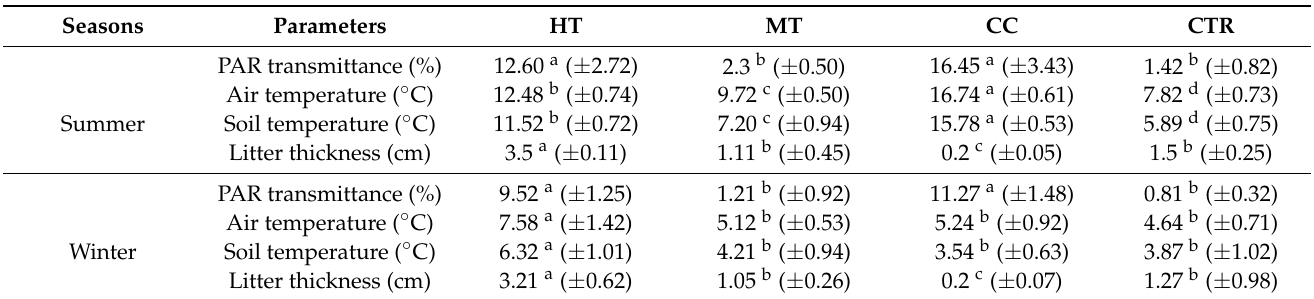
Table 1. Micro-environmental variables in high intensity thinning (HT), medium intensity thinning (MT), clear cut (CC), and control (CTR) plots in summer and winter. Different letters in the same row indicate, within each season, significant differences (Tukey’s test, p ≤ 0.05). The data are the means of two consecutive years (2014 and 2015). PAR: photosynthetically active radiation. Different letters in the same row show significant differences at p ≤